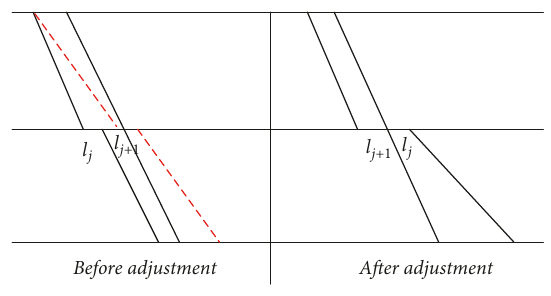
Figure 3: The condition of the strategy (4). Figure 4: The condition of the strategy